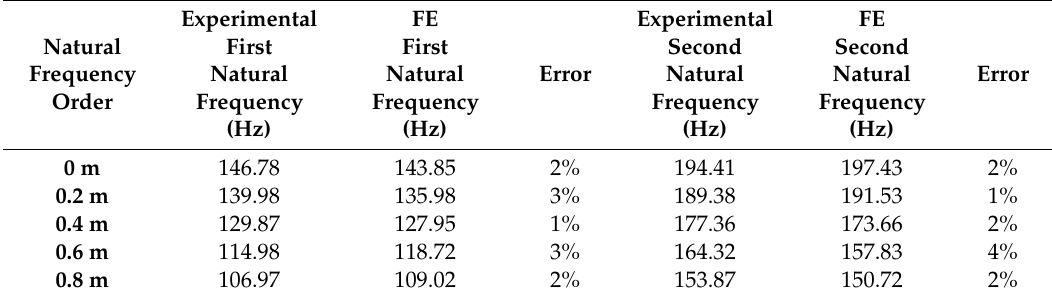
Table 3. Relationship between the natural frequency and liquid height.